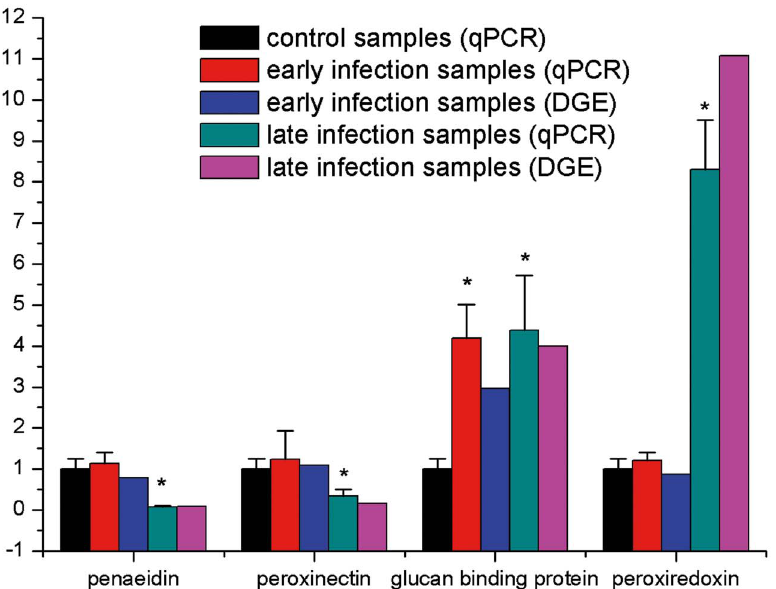
Figure 8. Real-time PCR analysis of four selected genes from L.vannamei which showed different expression after WSSV infection based on deep sequencing analysis. Bars with asterisks indicated values that were significantly different (P , 0.05) from control samples. Error bars indicated standard deviations of averages from three replicates. doi:10.1371/journal.pone.0076718.g008 PLOS ONE |